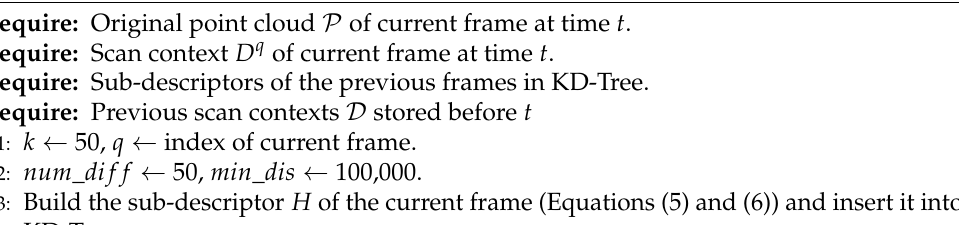
Algorithm 1 Tree-stage search